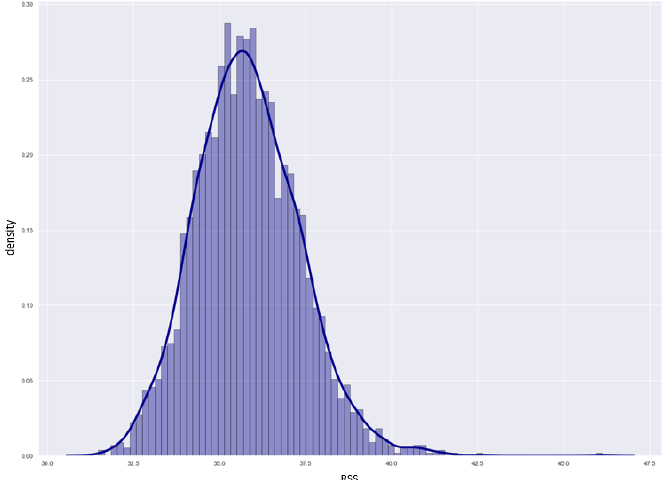
Figure 6. RSS distribution of meteorological data from Lakkomata. The RSS values of all other subregions are out of scale: Kalochori 102.13, Lithia 158.09, Argos Orestiko 168.51 and Polykarpi 146.69.